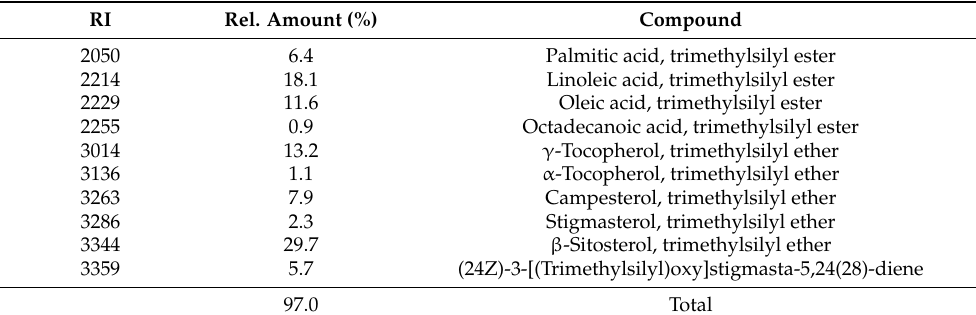
Table 3. Composition of the GC-MS-analyzable silylated C. sativa seed oil.